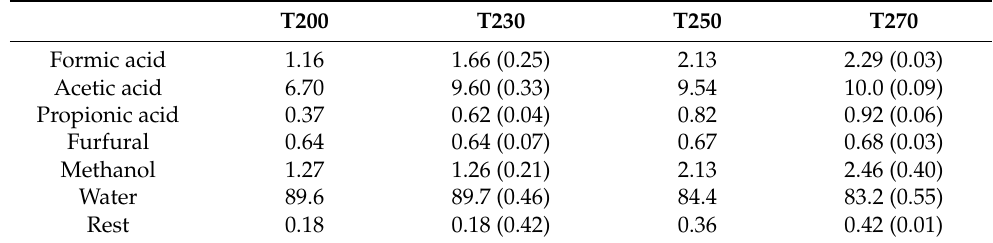
Table 4. Composition of condensable compounds in torr-gas (wt.%). Numbers in parentheses indicate the standard deviations for triple analyses.